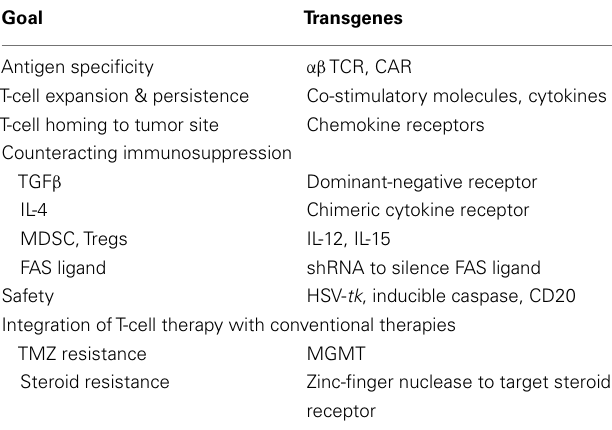
Table 1 | Genetic modification of T cells .